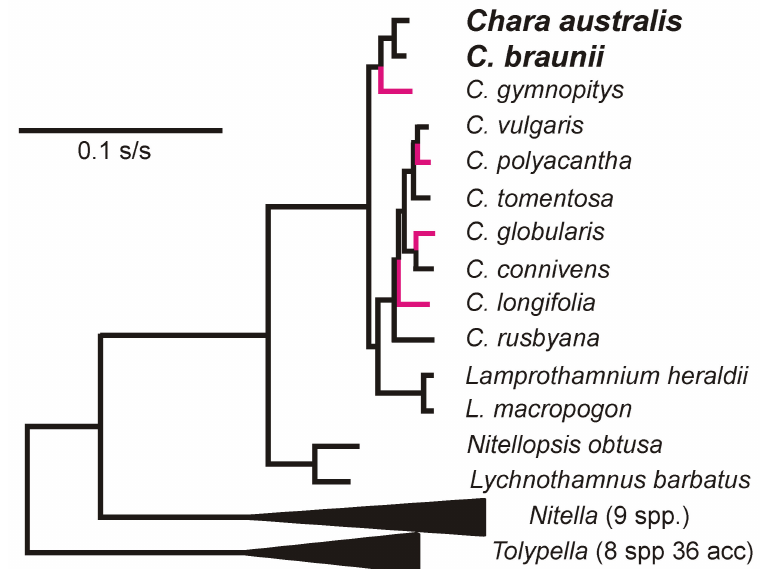
Figure 5. Molecular phylogeny of charophytes as determined by Perez et al. [49], with four additional species (red branches) extrapolated from the data of Sakayama et al.